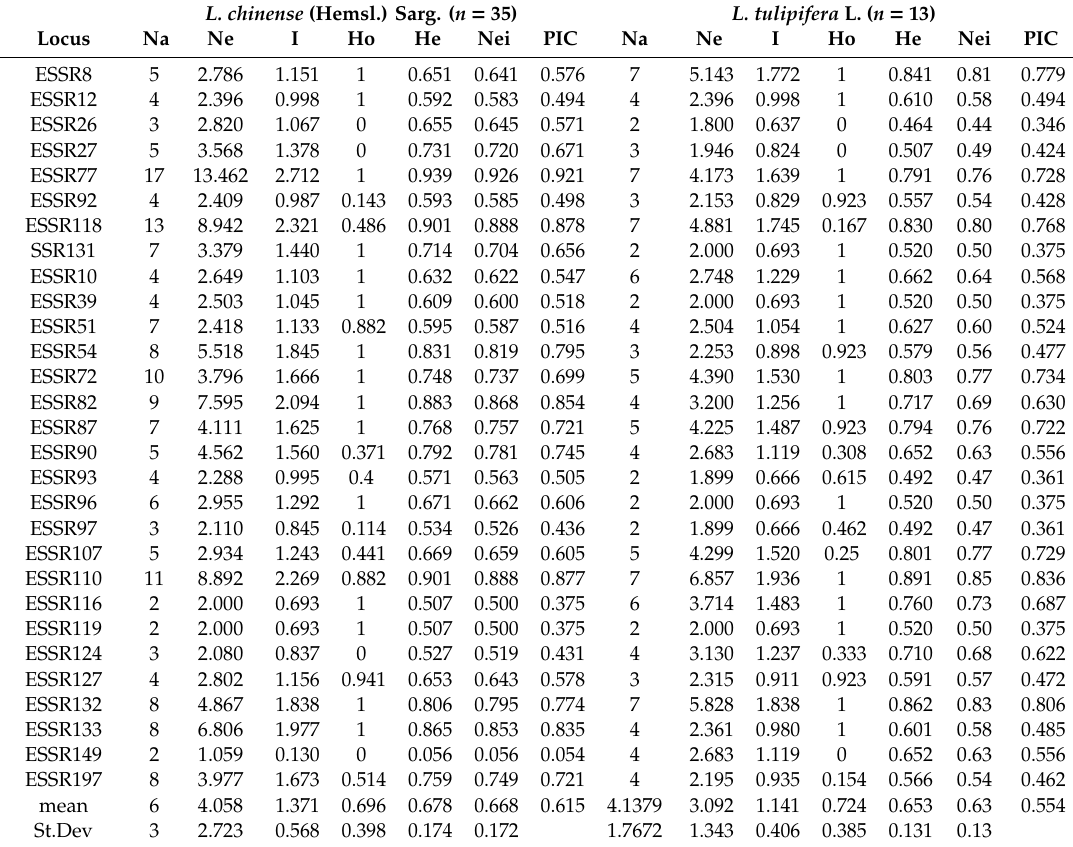
Table 2. Results of primer screening in L. chinense and cross-species amplification in L. tulipifera . L. chinense (Hemsl.) Sarg. ( n =